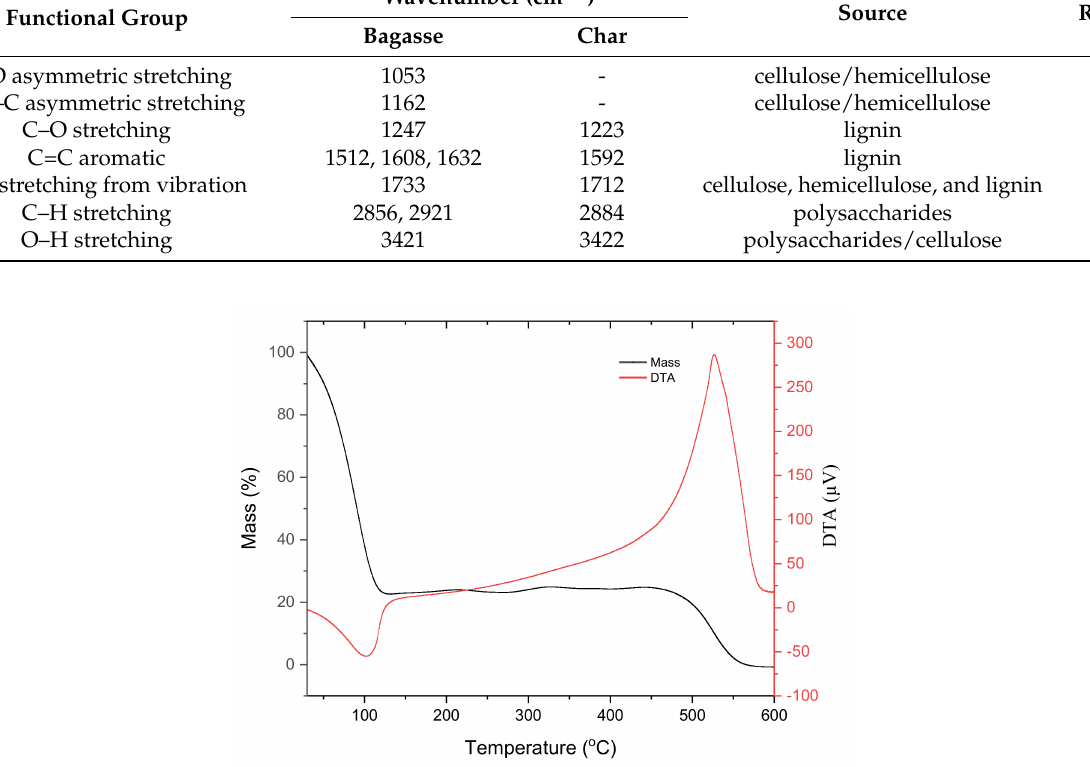
Figure 5. TG–DTA curve of the wet activated-carbon shows two steps of mass